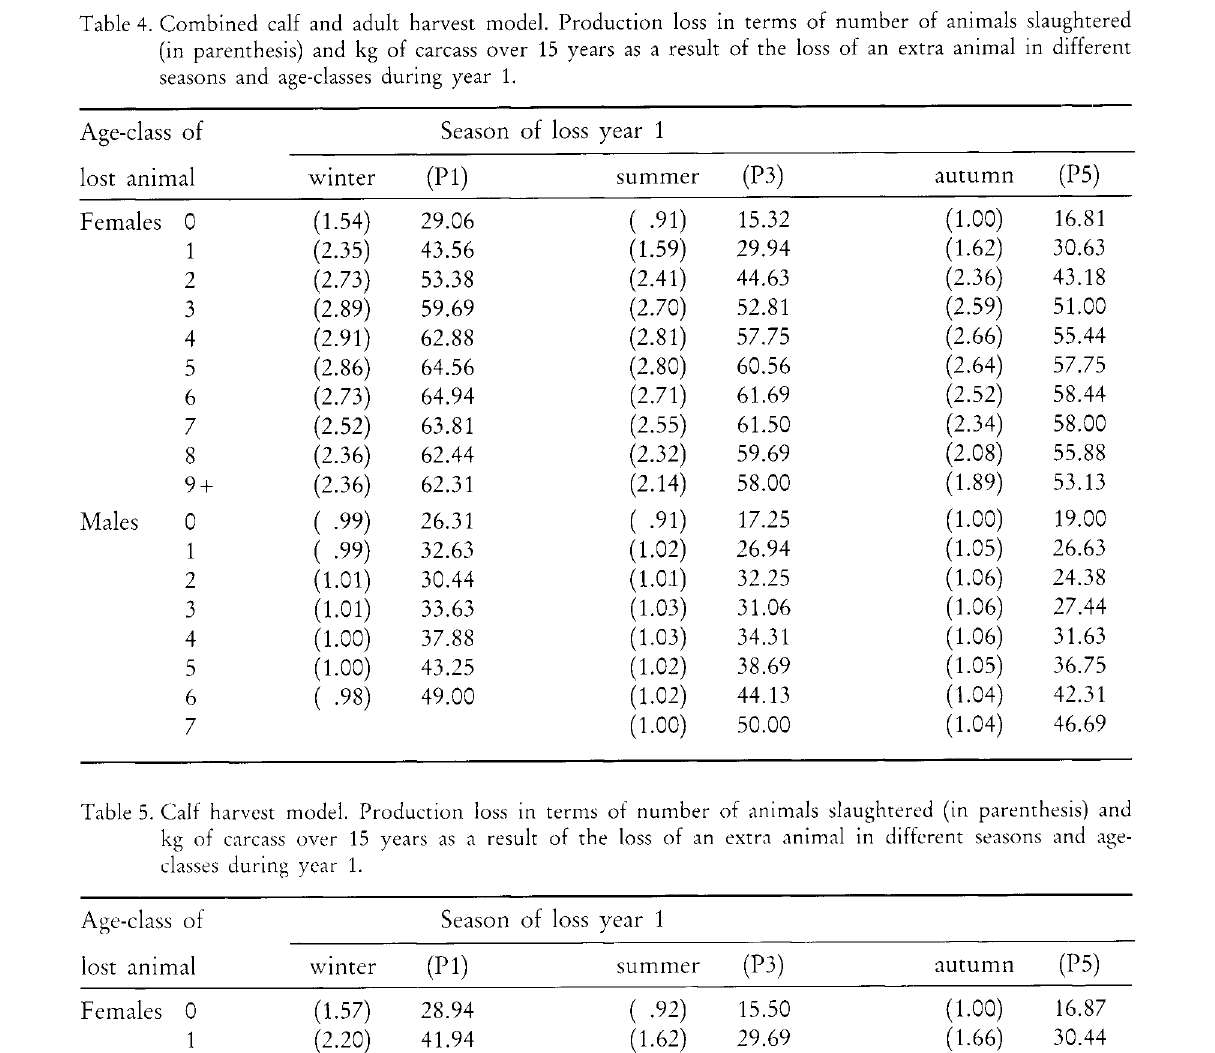
Table 4. Combined calf and adult harvest model. Production loss in terms of number of animals slaughtered (in parenthesis) and kg of carcass over 15 years as a result of the loss of an extra animal in different seasons and age-classes during year 1.